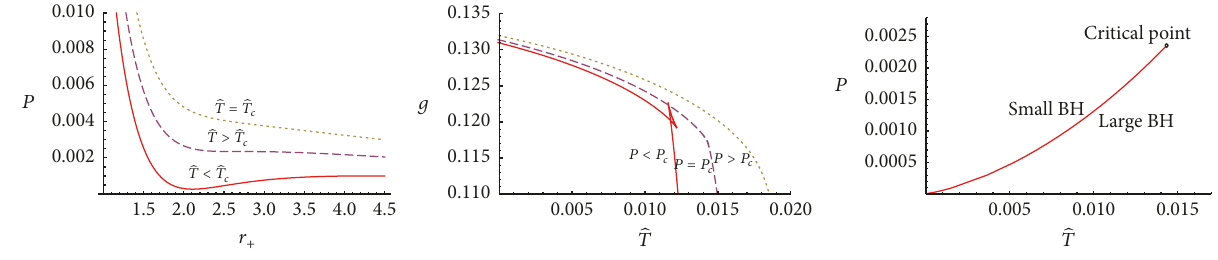
Figure 6: Born-Infeld AdS black holes for 𝑑 = 5 , 𝑤 2 = 0.001 , and 𝑤 3 = −0.02 .